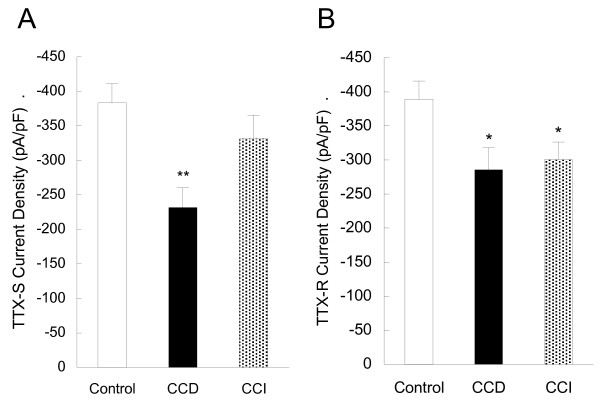
Alteration of TTX-R and TTX-S Na+ current densities in small DRG neurons after CCD and CCI treatment. Data shown here are from Fig. 2C, D, J and 2K and the data from the slow and fast neurons are combined. CCI-induced significant alteration in TTX-S current density in the slow neurons (see Fig. 2) is hidden, while CCD-induced change in TTX-S currents still exhibit clearly (A). Both CCD- and CCI-induced reduction in TTX-R currents density is unchanged in this analysis (B).